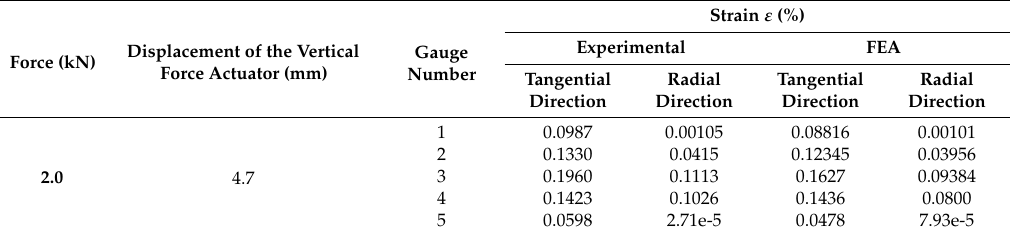
Table 5. Maximum strain values obtained on the composite plate in the five locations. Force